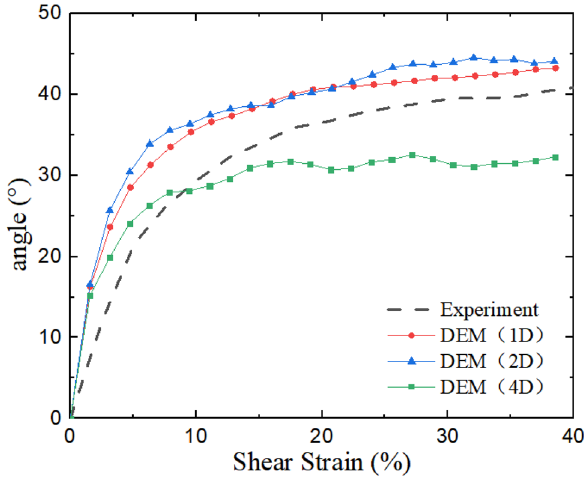
Figure 5. Rotation of principal stresses.